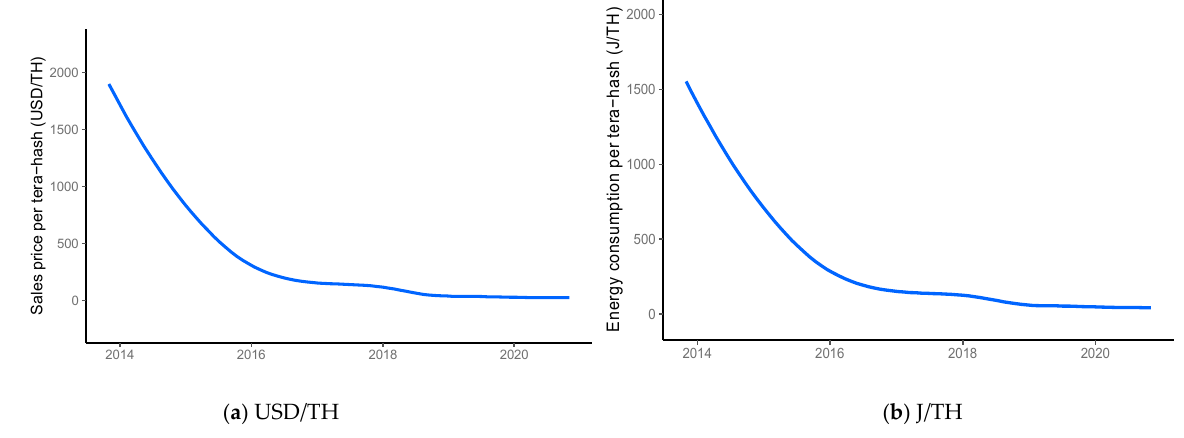
Figure 1. Energy demand and sales price per tera-hash. This figure plots the evolution of ASICs in terms of energy efficiency ( a ) and sales price ( b ) per tera-hash computing power (November 2013–June 2020) [43].